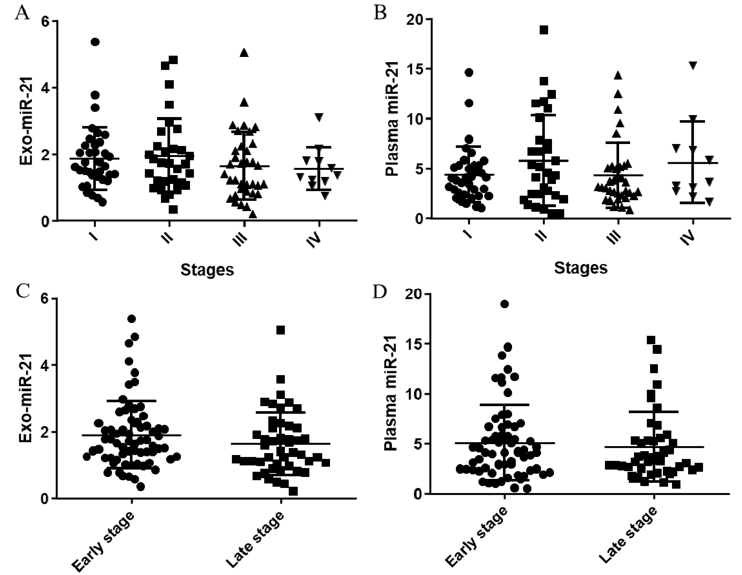
Figure 1. Distributions of the relative expression of plasma miR-21 and exo-miR-21 in stages. ( A ) Distributions of the relative expression of exosomal miR-21 in all stages. ( B ) Distributions of the relative expression of plasma miR-21 in all stages. ( C ) Distributions of the relative expression of exosomal miR-21 in early stage and late stage. ( D ) Distributions of the relative expression of plasma miR-21 in early stage and late stage.